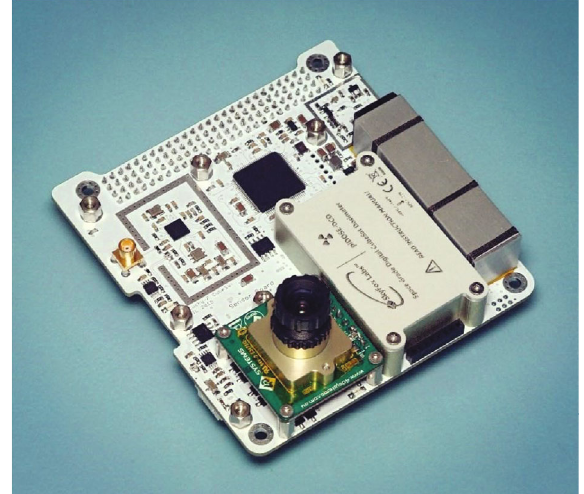
Figure 3: Scienti fi c module. The GPS is integrated directly into the scienti fi c board PCB. The shielding of the RF front end is removed. The module further integrates the camera, dosimeter, and spectrometer.